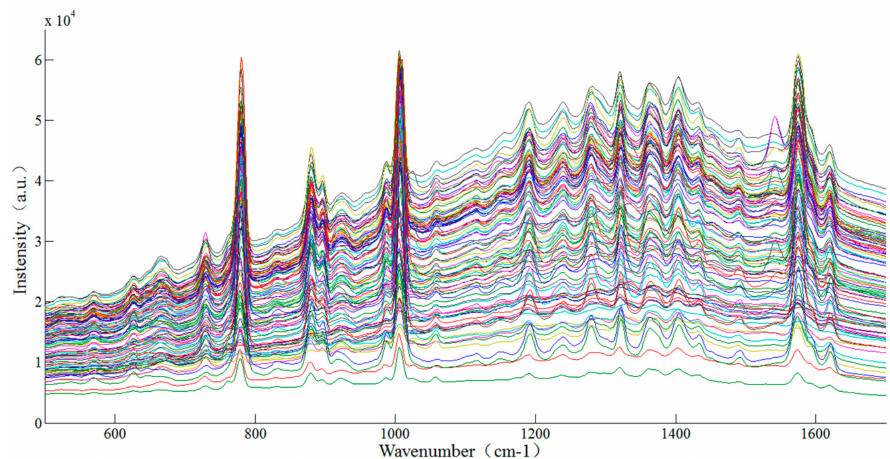
Figure 6. SERS spectra of different concentrations of thiabendazole pesticides in